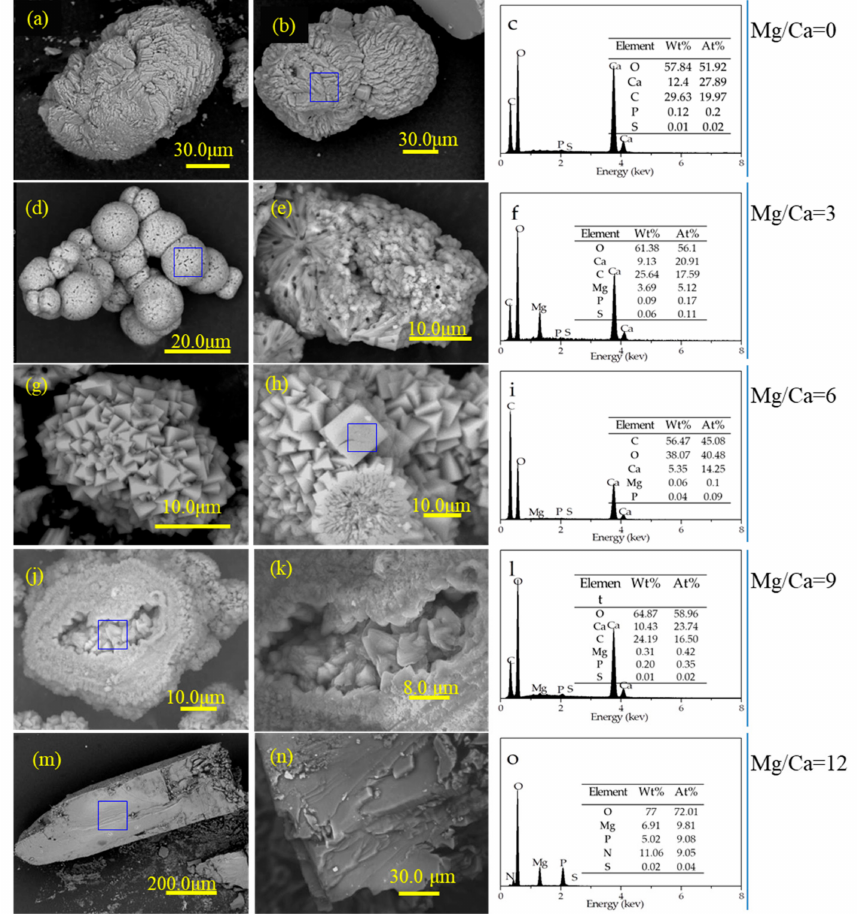
Figure 4. Scanning electron microscope (SEM) and Energy dispersive spectrum (EDS) images of minerals precipitated in the culture mediums at di ff erent Mg / Ca ratios: ( a , b , d , e,g , h , j , k , m , n ) are morphologies of minerals at Mg / Ca molar ratios of 0, 3, 6, 9 and 12, respectively; ( c , f , i , l , o ) are the EDS analyses of minerals marked by a blue square in a2, b1, c2, d1 and e1,